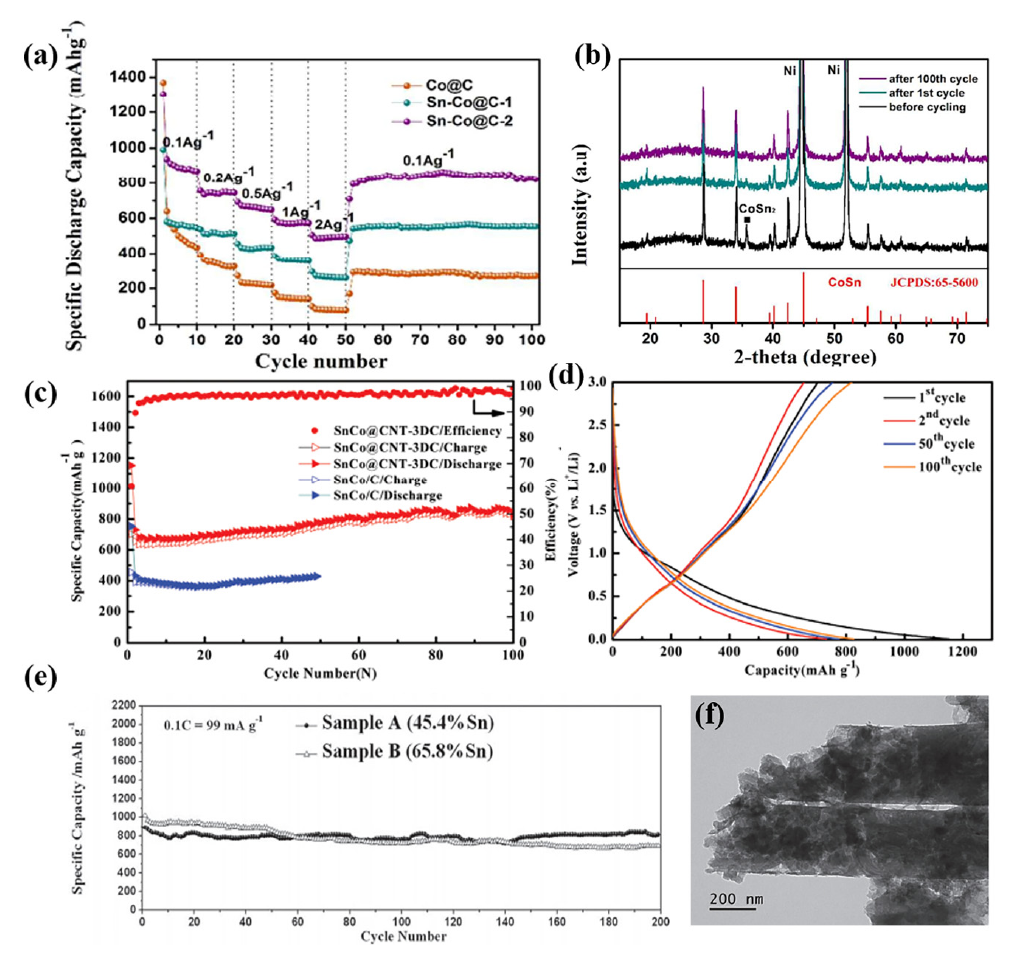
Figure 9. Electrochemical performances of cobalt-based anode materials. ( a ) Rate performances